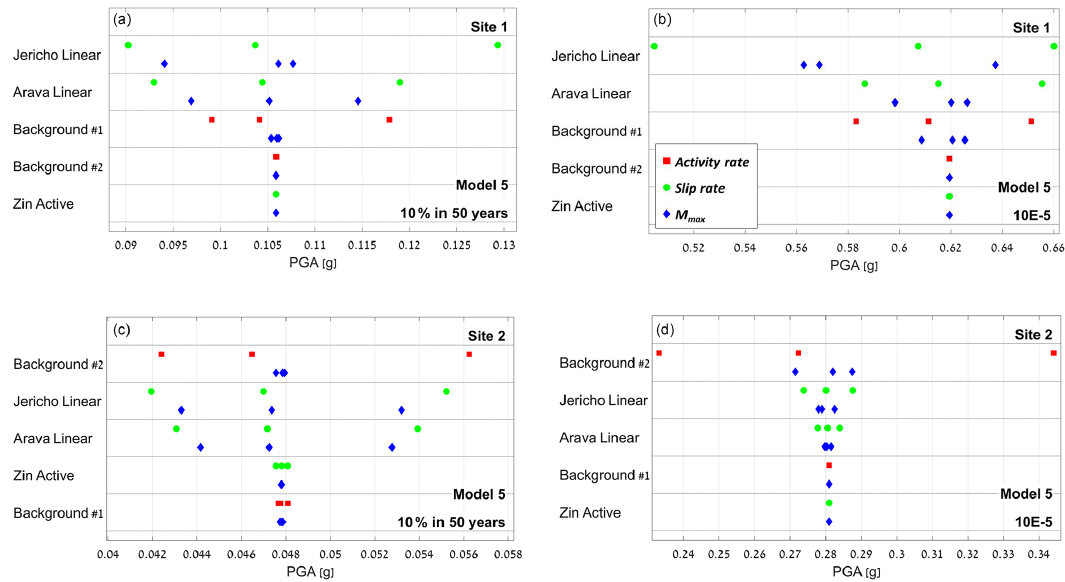
Figure 11. Tornado plots for PGA only, showing the contribution of parametric uncertainty to the hazard for (a) site 1, 10% in 50 years, (b) site 1, 10E − 5 , (c) site 2, 10% in 50 years, and (d) site 2, 10E − 5 .